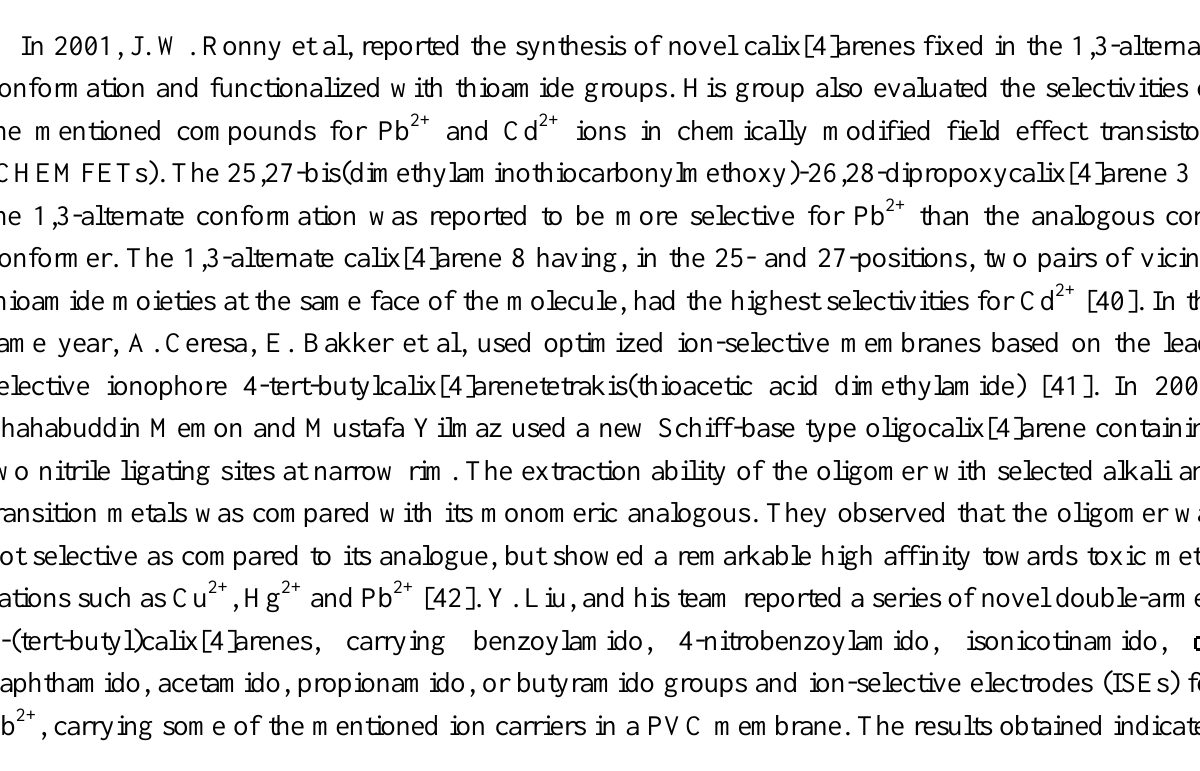
Figure 18. meso -octamethylcalix[4]pyrrole ( A ), meso -octaethylcalix[4] pyrrole ( B ), and tetraspirocyclohexylcalix[4]pyrrole ( C